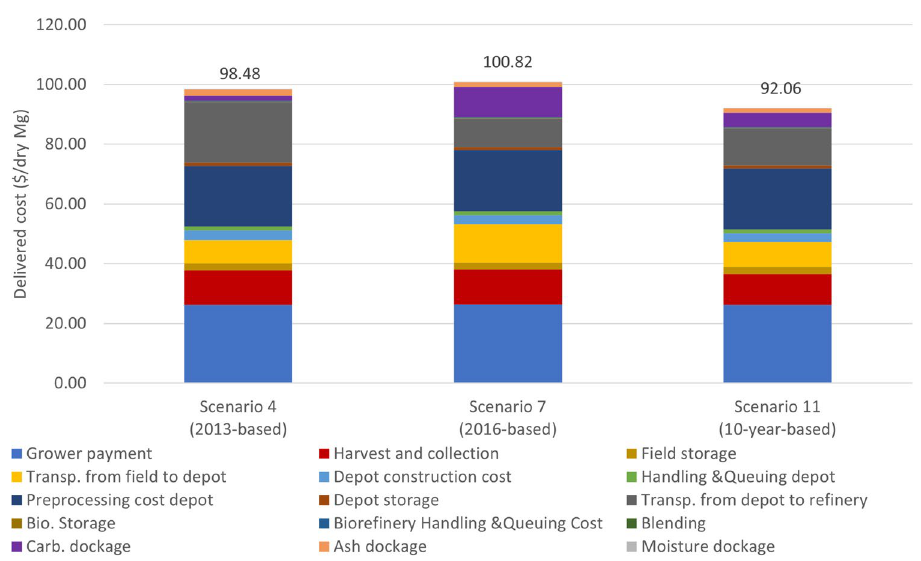
Figure 6. Cost ($/dry Mg) breakdown of scenario 4, 7 and 11 while supply chain is optimized based on single- and multi-year